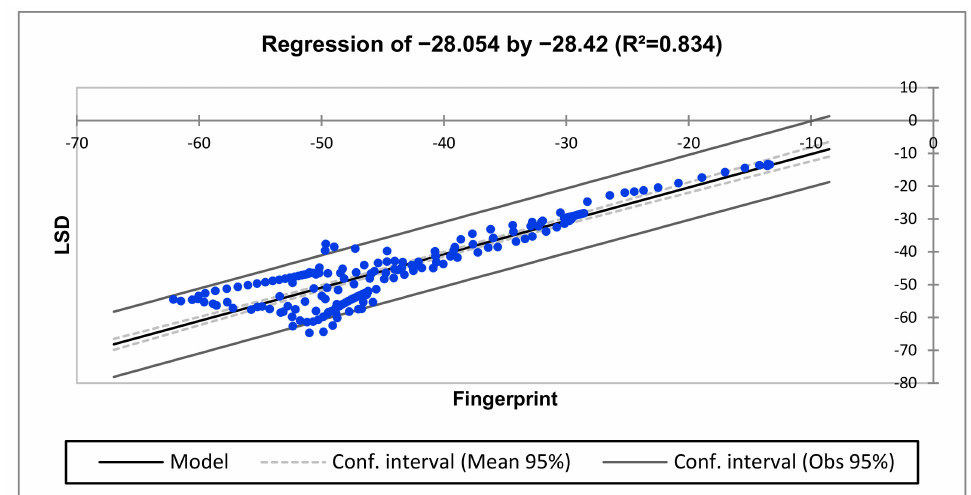
Figure 19. Regression for H2-H1 vs. H3-H2 (medium-frequency region).